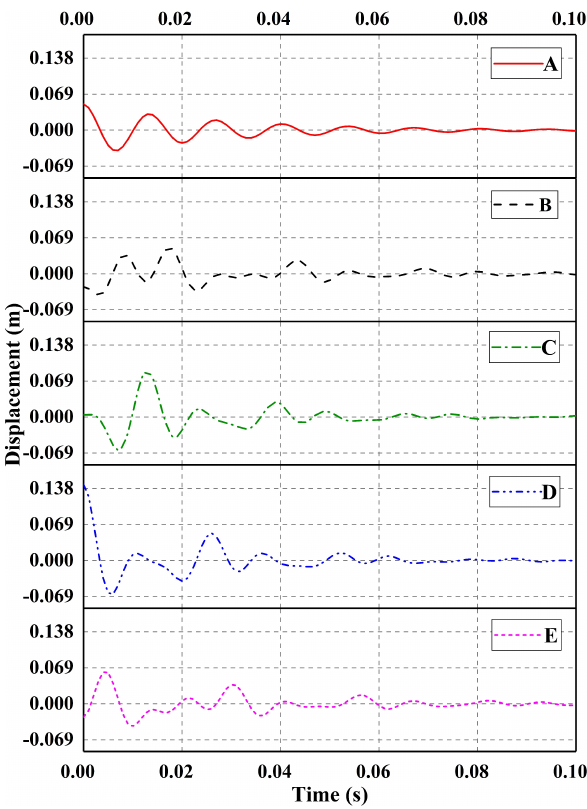
Figure 6: Displacement time-history curves of each feature point of nonlinear vibration